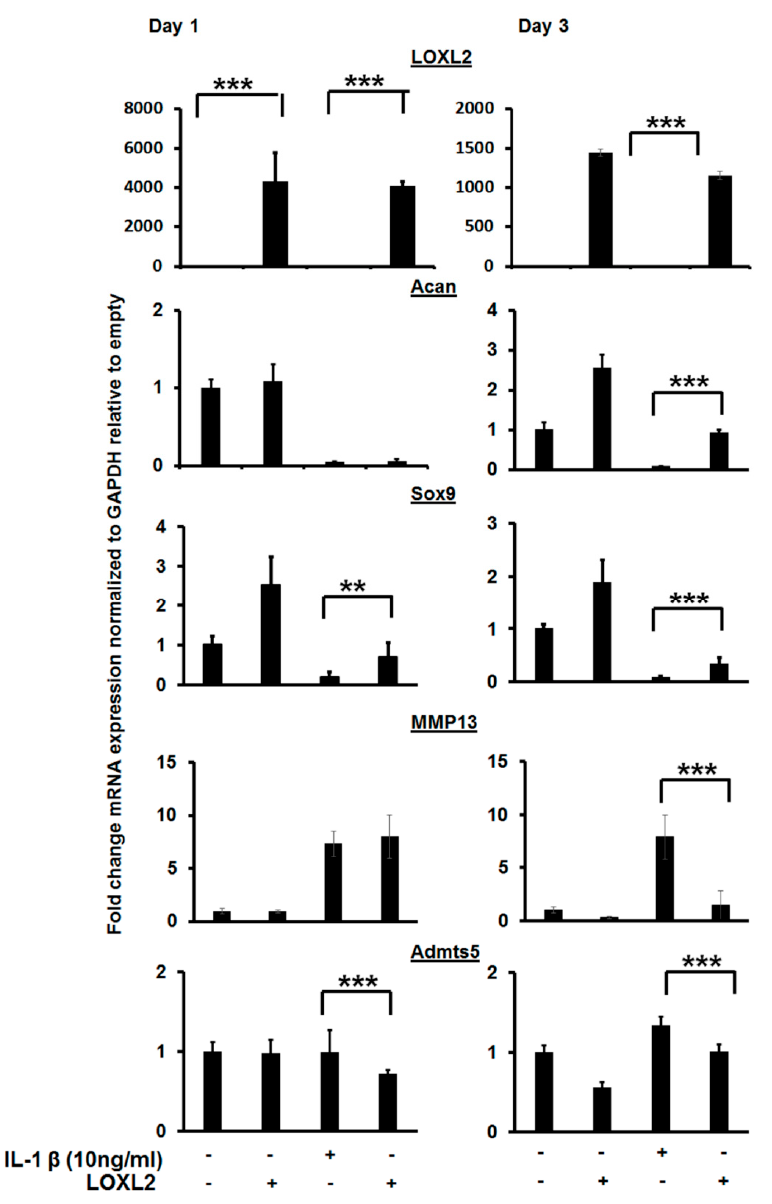
Figure 3. LOXL2 protects against IL-1 β -induced effect on cartilage-specific gene expression. RT-qPCR analysis of IL-1 β treated ATDC5 cells reduces cartilage-specific gene expression (Acan, Sox9), and LOXL2 protects against this effect. The minus ( − ) sign represents absence; plus (+) presence of LOXL2 or IL-1 β in the respective group. The statistically significant differences in protein or mRNA levels were evaluated by one-way ANOVA with Bonferroni correction (** p < 0.01; *** p < 0.001; ANOVA). 2.3. Enzymatically Inactive LOXL2 also Attenuates IL-1 β -Induced NF- κ B Activity. IL-1 β induced phosphorylation of NF- κ B/p65, but this was attenuated by the overexpression of LOXL2 (Figure 4A,B). To test if the anti-catabolic effect of LOXL2 is mediated by an enzymatic or non-enzymatic mechanism, ATDC5 cells were treated with IL-1 β and Adv-LOXL2 in the presence or absence of the LOX family inhibitor β -aminoproprinytryl (BAPN). The abilitry of LOXL2 expression